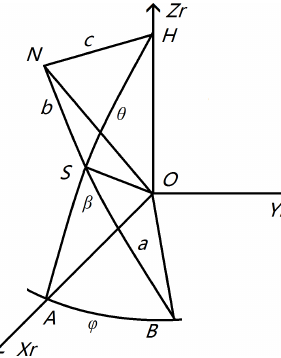
Figure 5. Model of the panel incidence